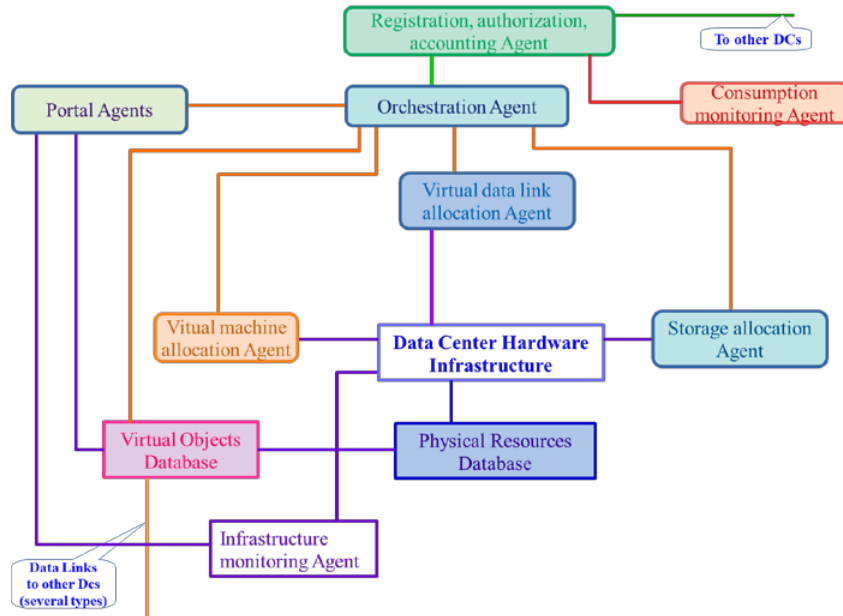
Fig. 1. The Distributed Operating Management System